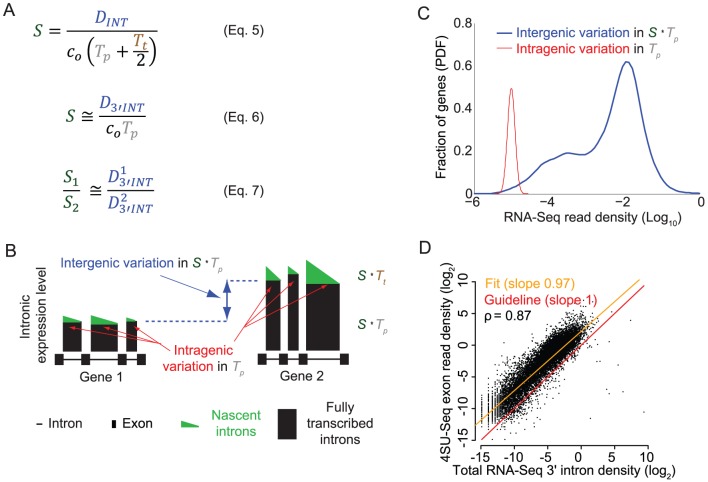
Average expression of the 3′ ends of introns across a gene is an accurate measure of mRNA synthesis rate.(A) Equations relating the mRNA synthesis rate S to RNA-Seq density across introns (DINT) or across the 3′ ends of introns (D3′INT). Tp is intron processing time, and c0 is a constant relating RNA-Seq read density to transcript number per cell. In Eq. (7), subscripts 1-2 and superscripts 1-2 refer to separate genes. (B) The expression levels of the 3′ ends of introns are a useful proxy for mRNA synthesis rates, assuming that the variation in intron processing times among introns is smaller than the variation in mRNA synthesis rates among genes. The schematic shows the contributions of mRNA synthesis and intron processing to expression at the 3′ ends of introns across two hypothetical genes, each with three introns. The second gene is transcribed at a higher rate. (C) The assumption stated in (B) holds true: the within-gene standard error of intron densities at the 3′ ends of the (D3′INT, red) is much smaller than the range of average D3′INT among genes (blue). For clarity, the distribution of standard errors of D3′INT is shown for the subset of genes with mean intron log-densities within 10% of -5 on the x-axis. Data is from mouse neuron RNA-Seq using SOLiD. (D) Quantification of mRNA synthesis using RNA labeling with 4-thiouridine (4SU, vertical axis) versus total RNA-Seq (D3′INT, horizontal axis). The two methods are correlated with a Spearman's ρ of 0.87. Each point represents one gene and is an average of three total RNA-Seq and three 4SU RNA-Seq samples (biological replicates) from a lymphocyte cell line. Cells were exposed to 4SU for five minutes before cell lysis. Sequencing was performed using the dUTP/Illumina method (total RNA) or standard Illumina RNA-Seq (4SU).